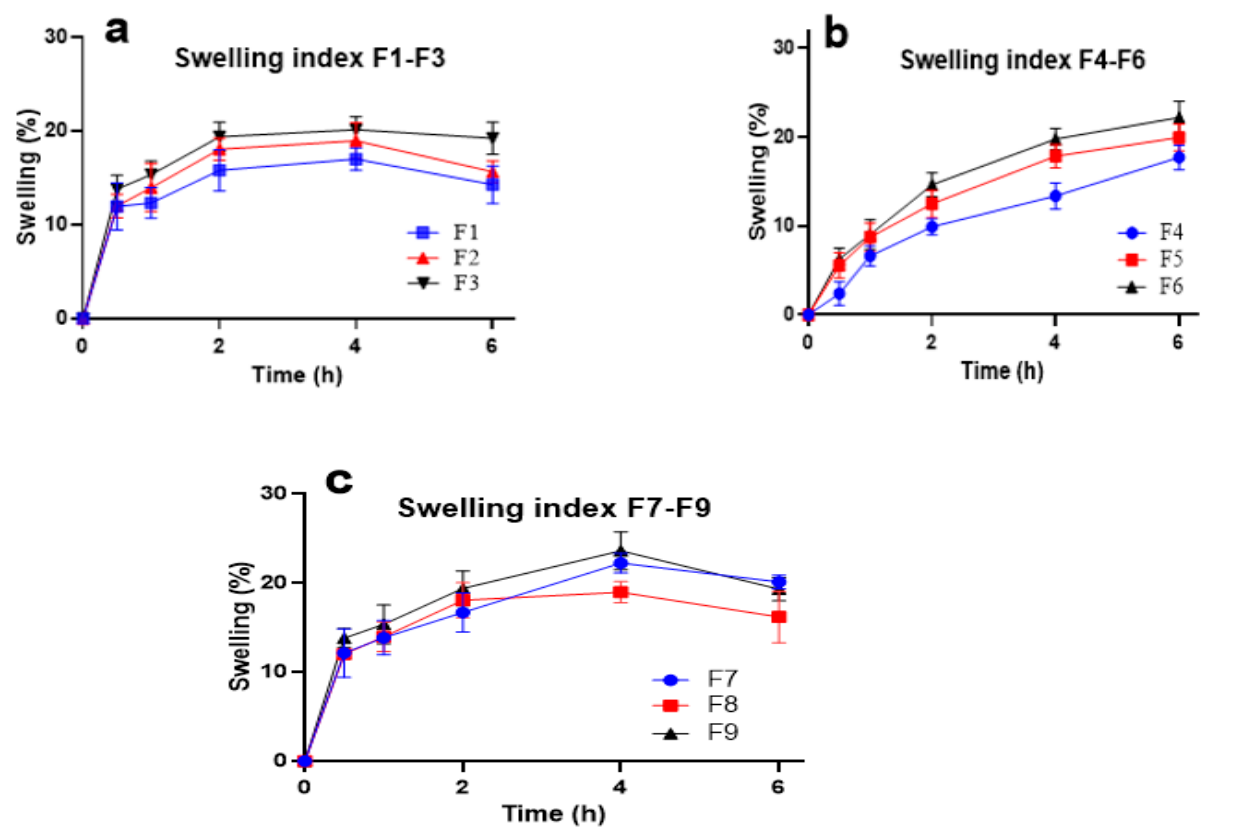
Figure 1. Swellability index of mucoadhesive formulations ( a ). F1–F3 ( b ). F4–F6 and ( c ). F7–F9.